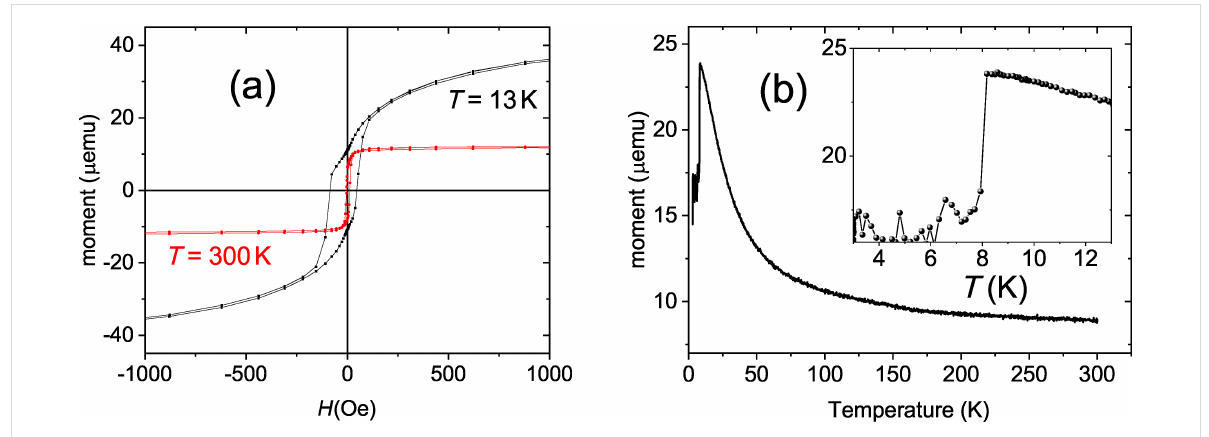
Figure 4: SQUID data of the s3 sample. (a) Hysteresis loop measured at T = 300 K (red) and T = 13 K (black). (b) Temperature dependence of the magnetic moment measured at H = 250 Oe. The inset shows the data in the vicinity of the superconducting transition.